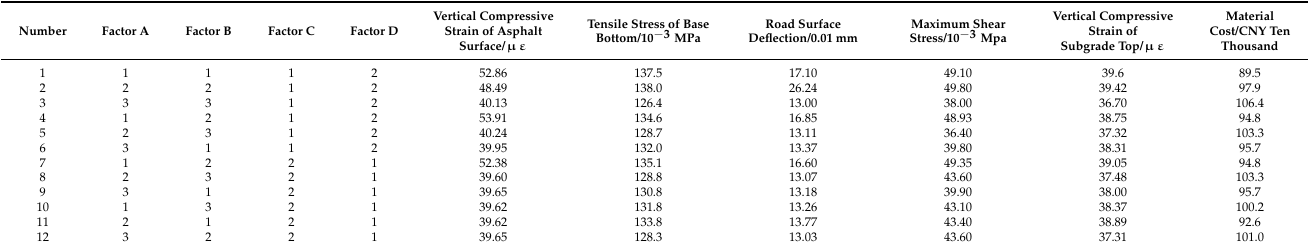
Table 5. Orthogonal test results for PU mixture composite pavement.